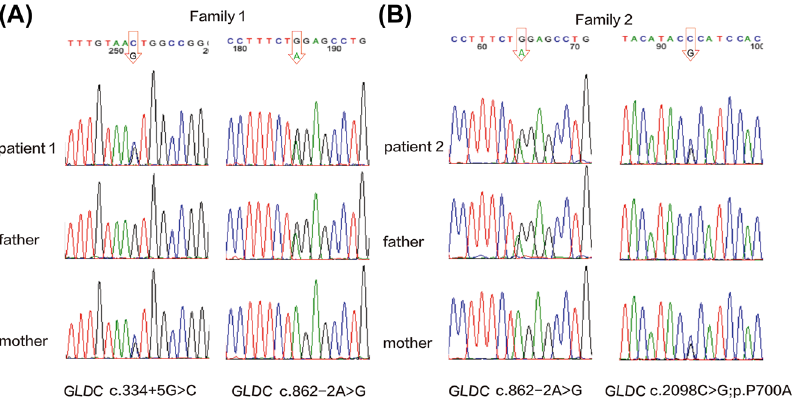
Figure 2: One missense variation and two splicing variations in two families. (A) Sequencing results of family 1. Sequence analysis of the GLDC gene separately identified the heterozygous c.334 + 5G>C variant in the probandin his mother,but not inhis father,and c.862-2A>Gvariantin the proband of his father,but not inhis mother.(B) Sequencingresults of family 2. In family 2, c.862-2A>G variant was identi fi ed in patient 2 and her father, c.2098C>G; p.P700A variation was identi fi ed in patient 2 and her